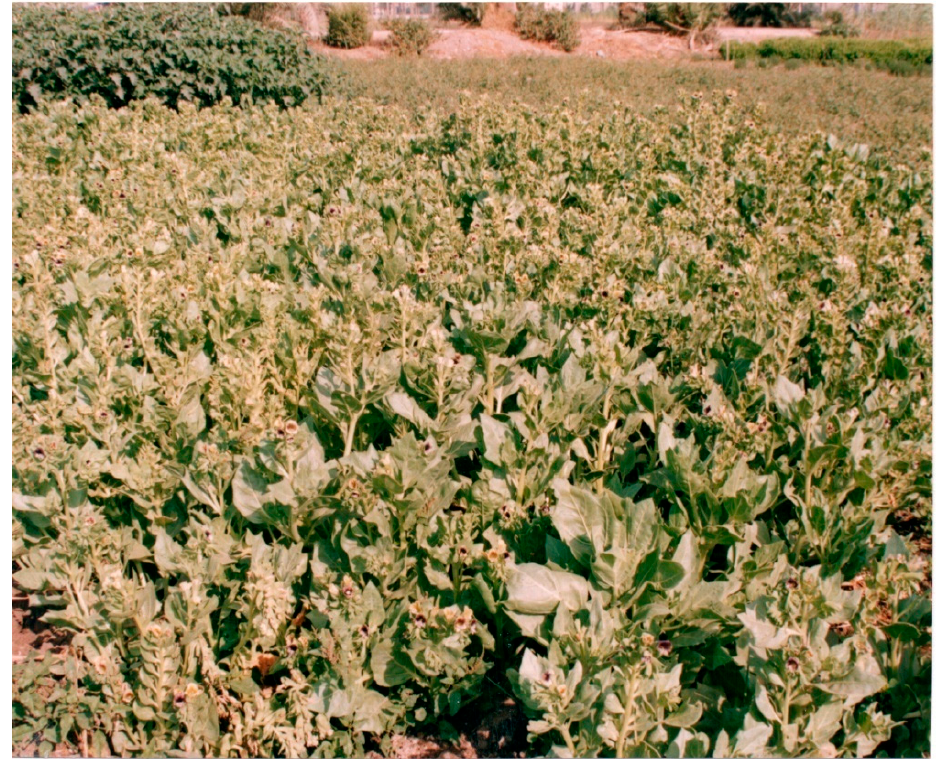
Figure 1. General view from the experiment at Egyptian henbane full blooming stage carried out in the second season (2018). second season